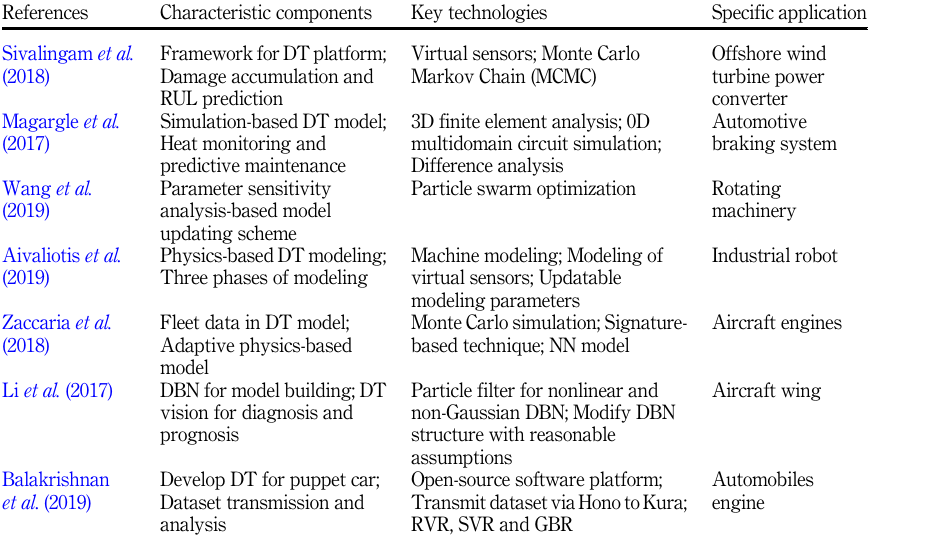
Table 5. Summary of